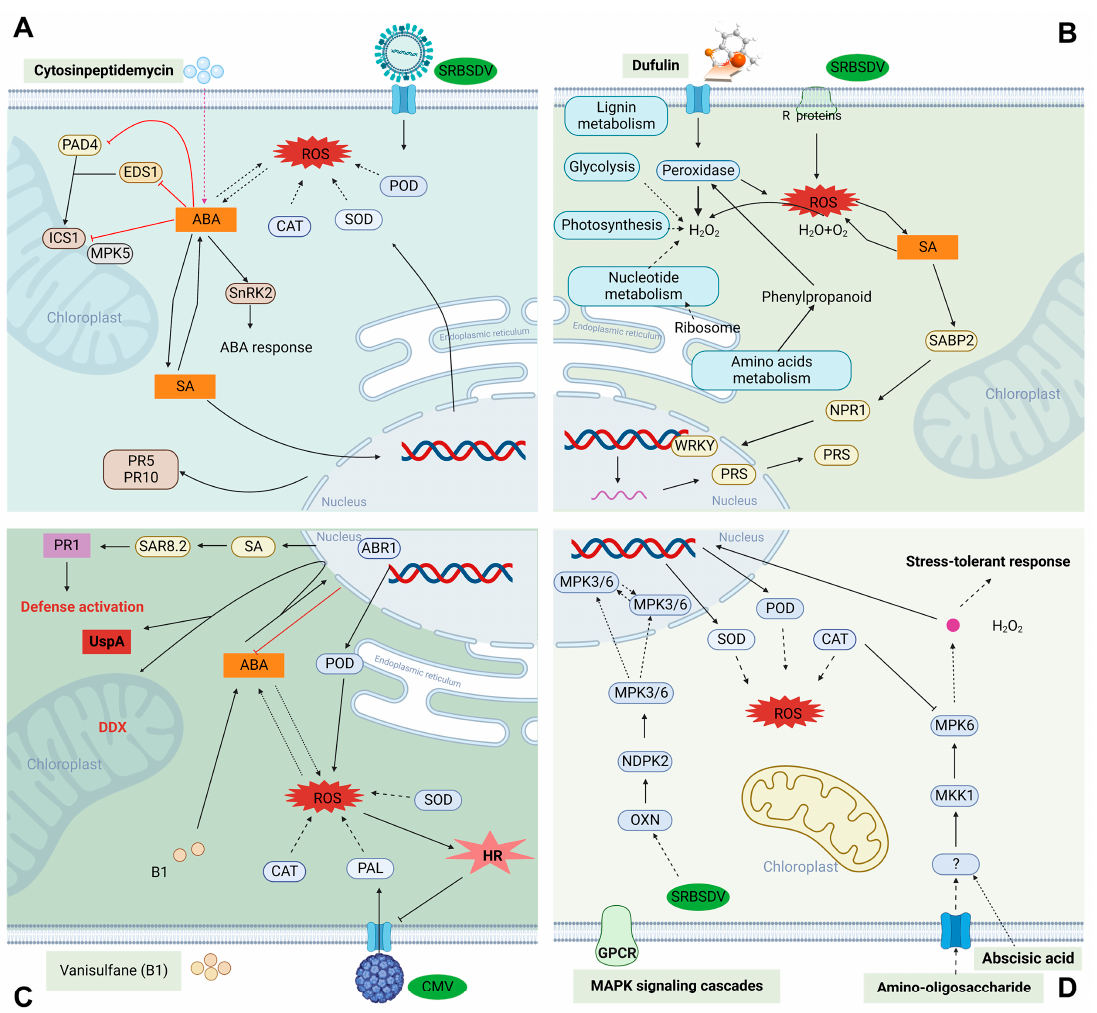
Figure 3. The action mechanism of plant immunity agents. ( A ) Cytosinpeptidemycin induces a